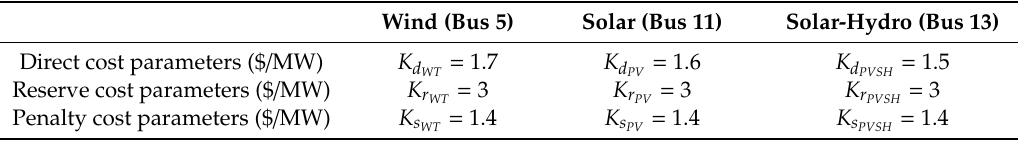
Table A1. Direct, reserve, and standby cost parameters for stochastic